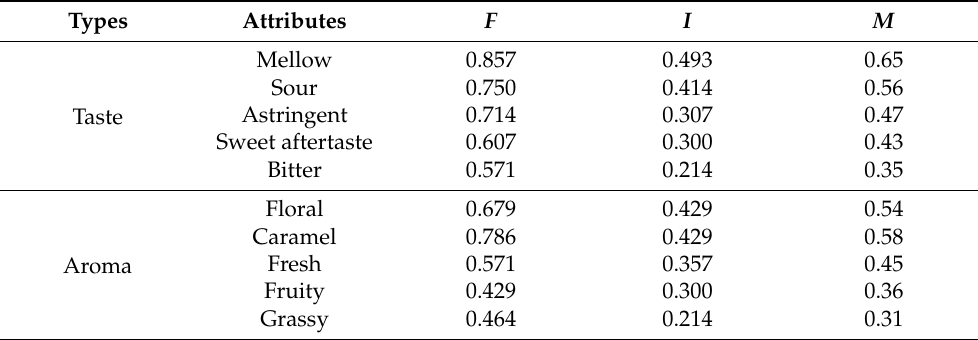
Table 2. The geometric mean ( M ) values of the sensory attributes of PCT.